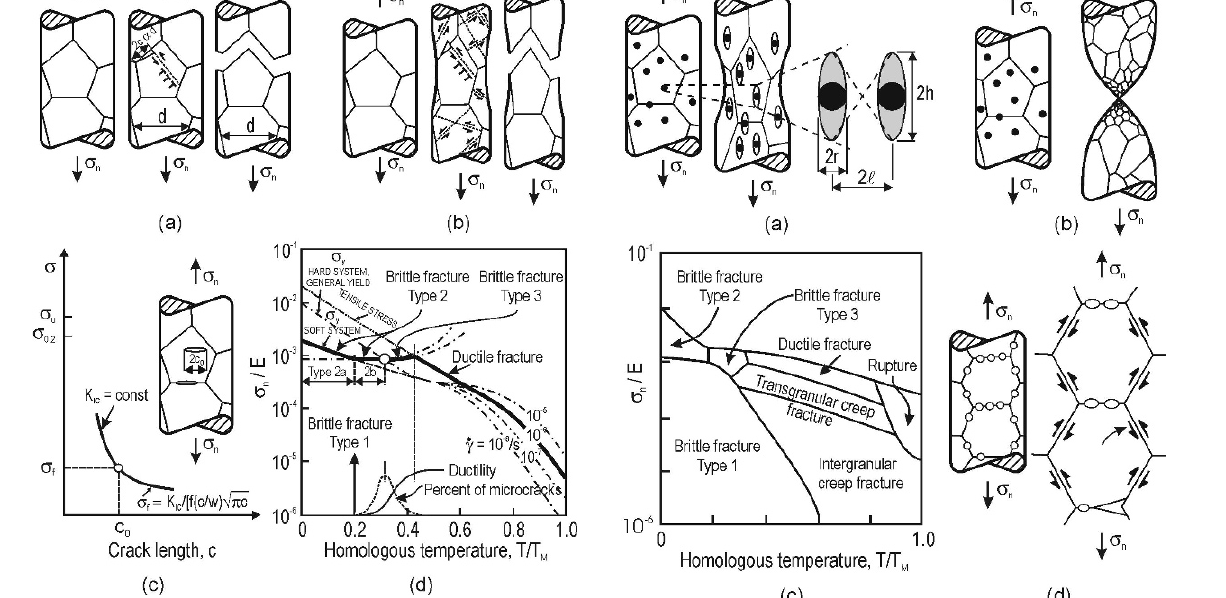
Figure 3. Mechanisms of non-brittle fracture: a) ductile, b) rupture, c) fracture mechanism map, d) intergranular creep frac- ture. Based on